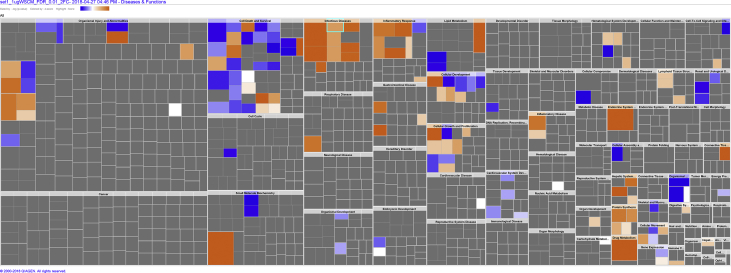
Square map showing the enriched disease and biological functions by medium WS-CM. The Square map was colored based on the z-score, which is a statistical measure of the match between expected relationship direction and observed gene expression. The color scale represents the activation z-score ranging from −1.301 (dark blue) to 1.774 (dark orange). Gray represents a z-score of 0. A z-score > 2 or < −2 is considered significant. The actual z-score is weighted by the underlying findings, the relationship bias, and dataset bias.